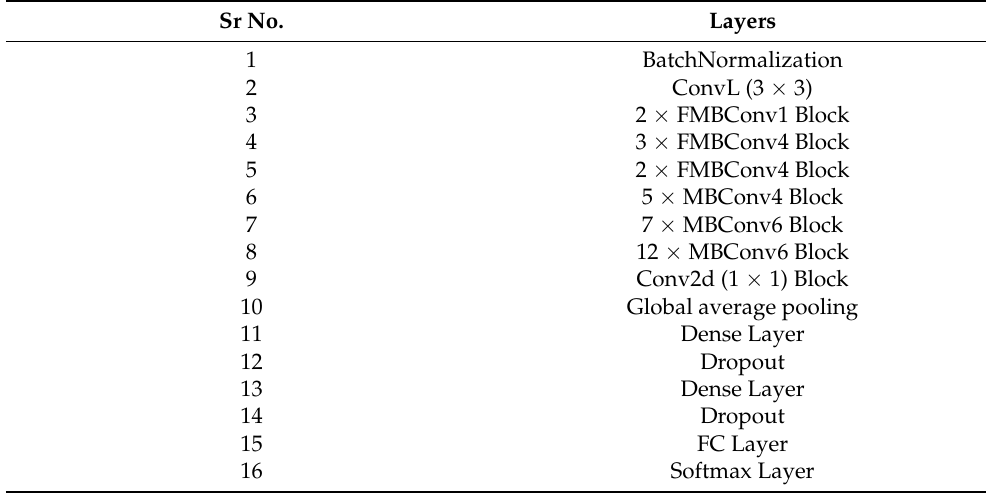
Table 1. Details of blocks and layers used in the proposed model. Sr